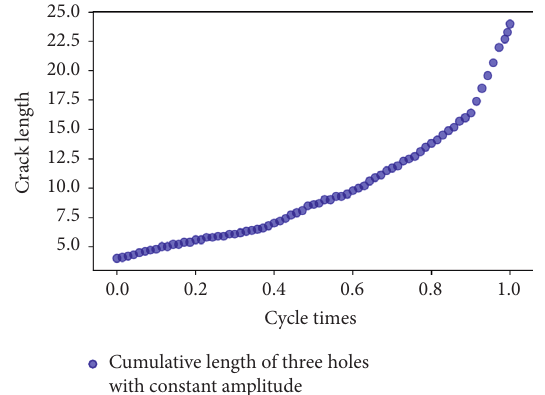
Figure 13: Cumulative length of three holes with constant amplitude.